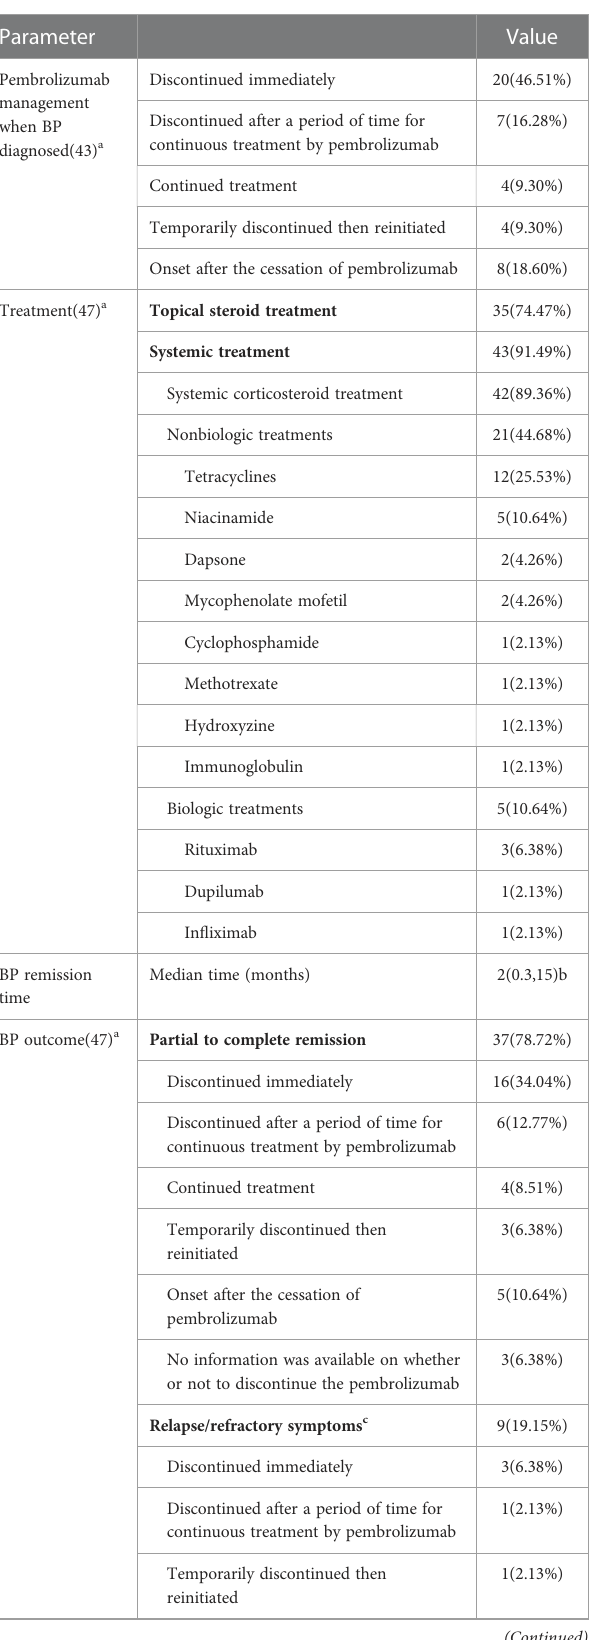
TABLE 3 Treatment and prognosis of the 47 reported in case series/